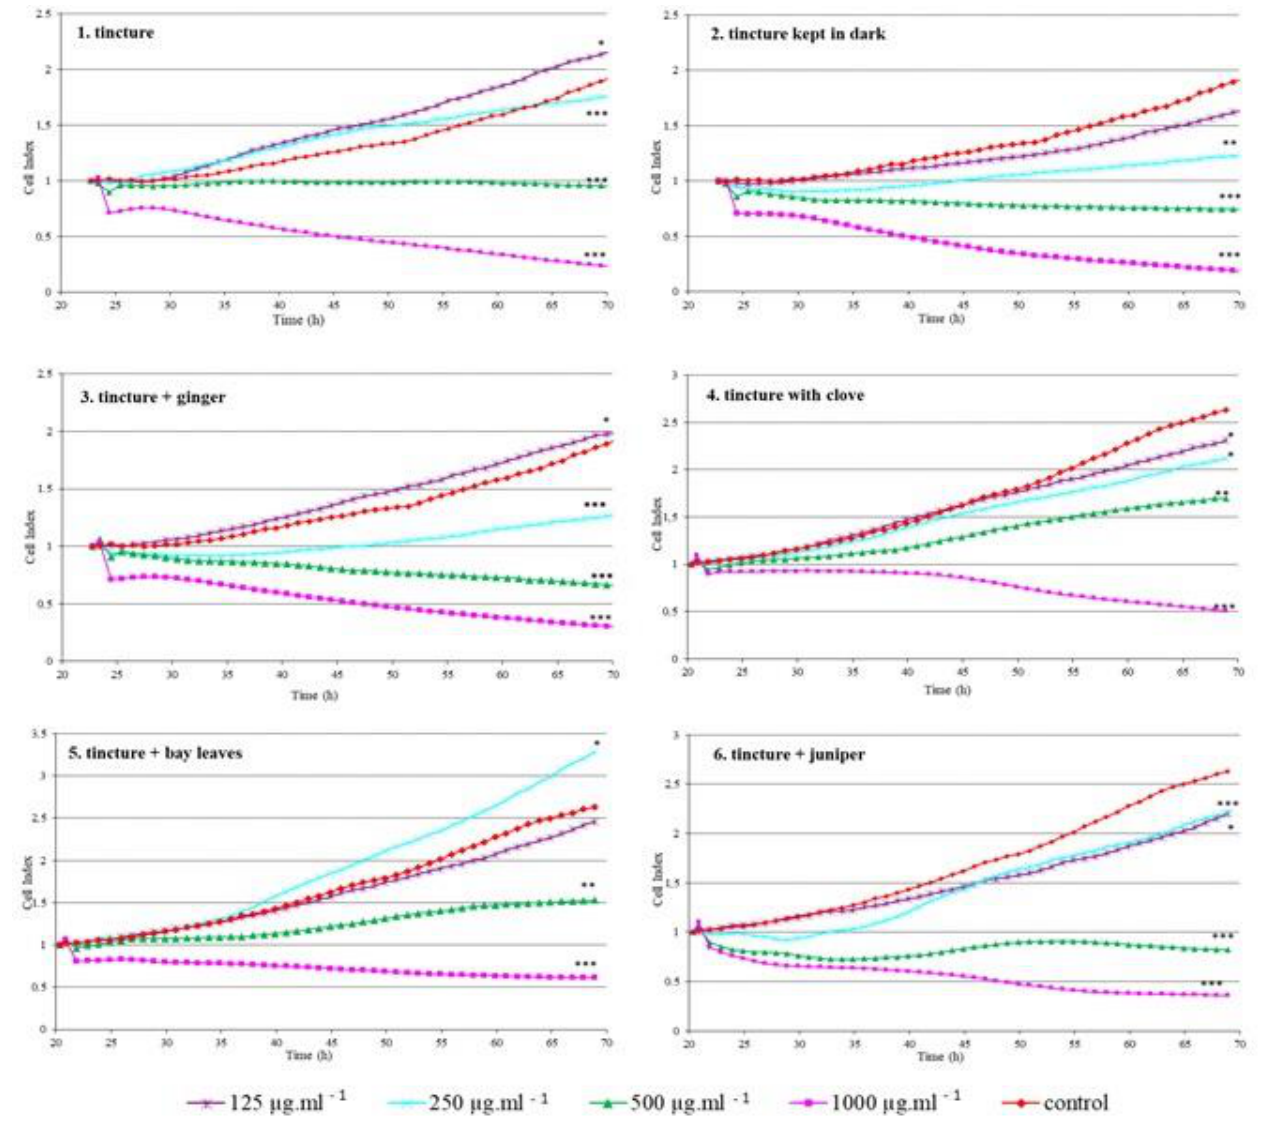
Figure 3. Real-time monitoring of cell response after exposure to tested substances (CI). Significant differences compared to control cells: *— p < 0.05, **— p < 0.001, ***— p < 0.0001.